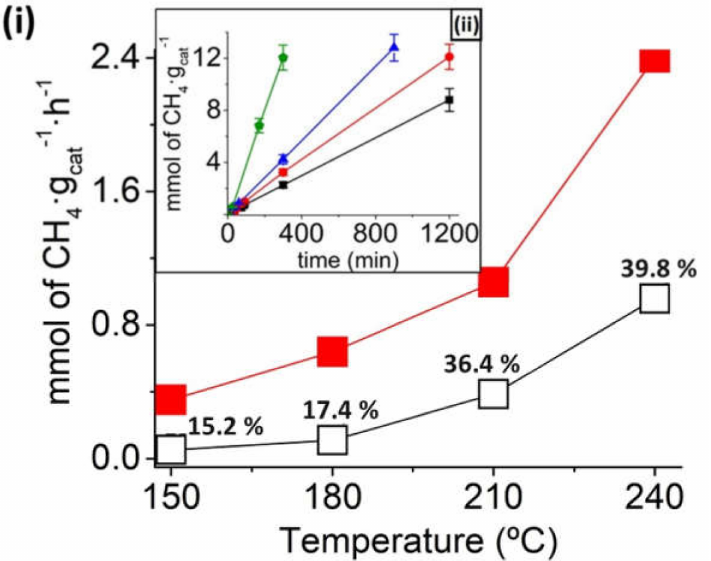
Figure 4. ( i ) Methane conversion rate for Ru/TiNT-3.5 as a function of the temperature for CO 2 hydrogenation upon irradiation with 100 mW/cm 2 light power ( ) and in the dark ( ). ( ii ) Methane conversion as a function of time for CO 2 methanation under 1 sun light power (equivalent to 100 mW/cm 2 ) at different temperatures ( ■ ) 150 °C, ( ● ) 180 °C, ( ▲ ) 210 °C, and 240 °C (